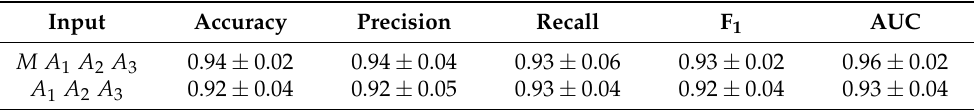
Table 3. Performance comparison of including or excluding the maternal channel in the proposed model (CNN-FSQI). Ten-fold cross-validation results from a single repetition are shown. [avg ±